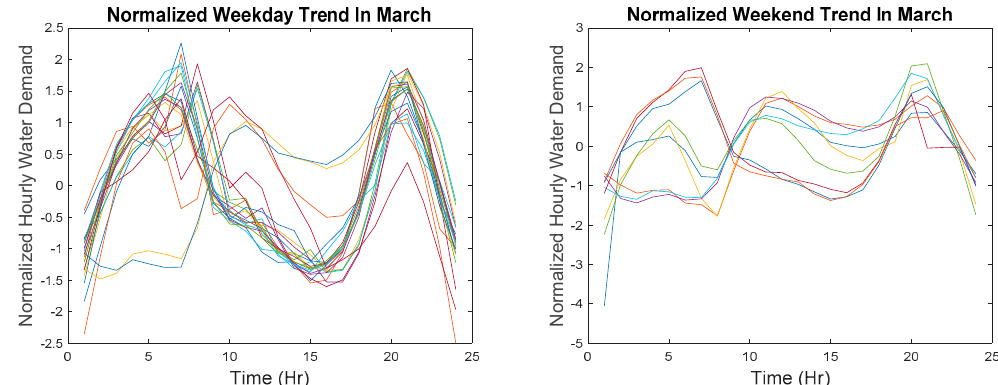
Figure 2. Weekday and weekend water demand trend.